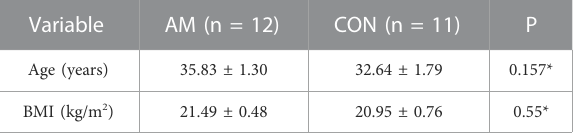
TABLE 2 Clinical characteristics of women with adenomyosis and control group for veri fi cation.